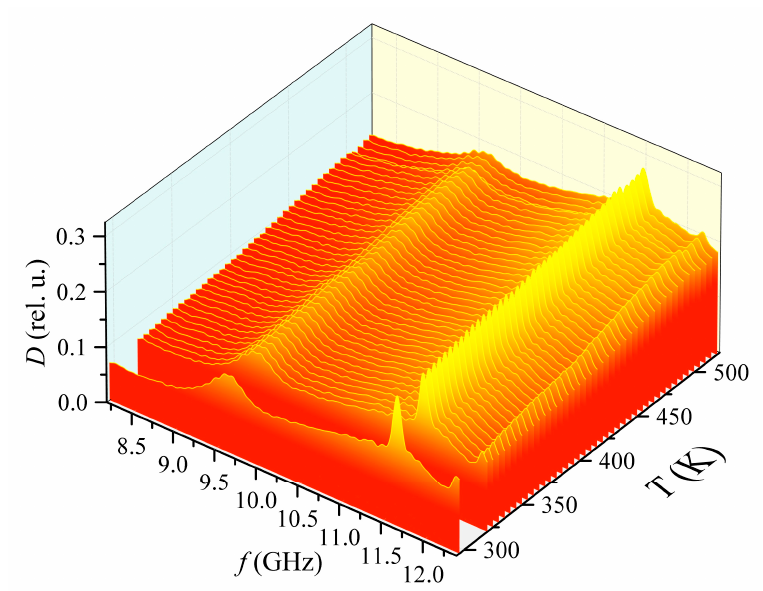
Figure 11. The dependence of the absorption coefficient on the frequency and temperature of the measuring cell with the fixture when heated. The color is chosen for contrast, and to make this 3D pattern easier to associate with 2D heat maps.